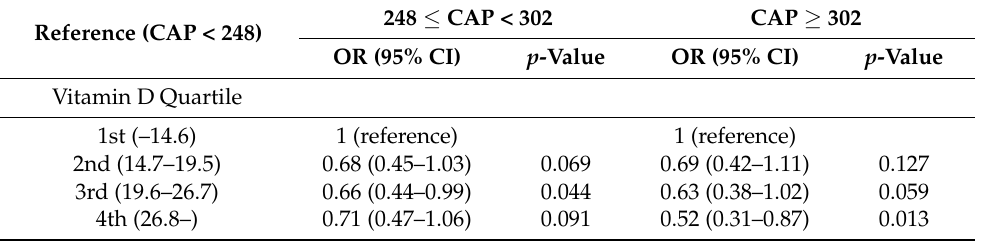
Figure 1. The prevalence of vitamin D sufficiency ( ≥ 20 ng/mL) according to the grade of hepatic steatosis. Compared using chi-square test. CAP, controlled attenuation parameter. Table 5. Multivariate analysis for the association between grade of hepatic steatosis and vitamin D.